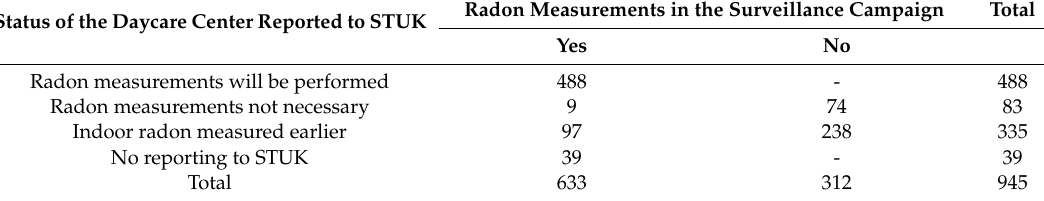
Table 1. Status of the daycare centers reported to Radiation and Nuclear Safety Authority (STUK) and whether the indoor radon measurements were performed in the campaign.